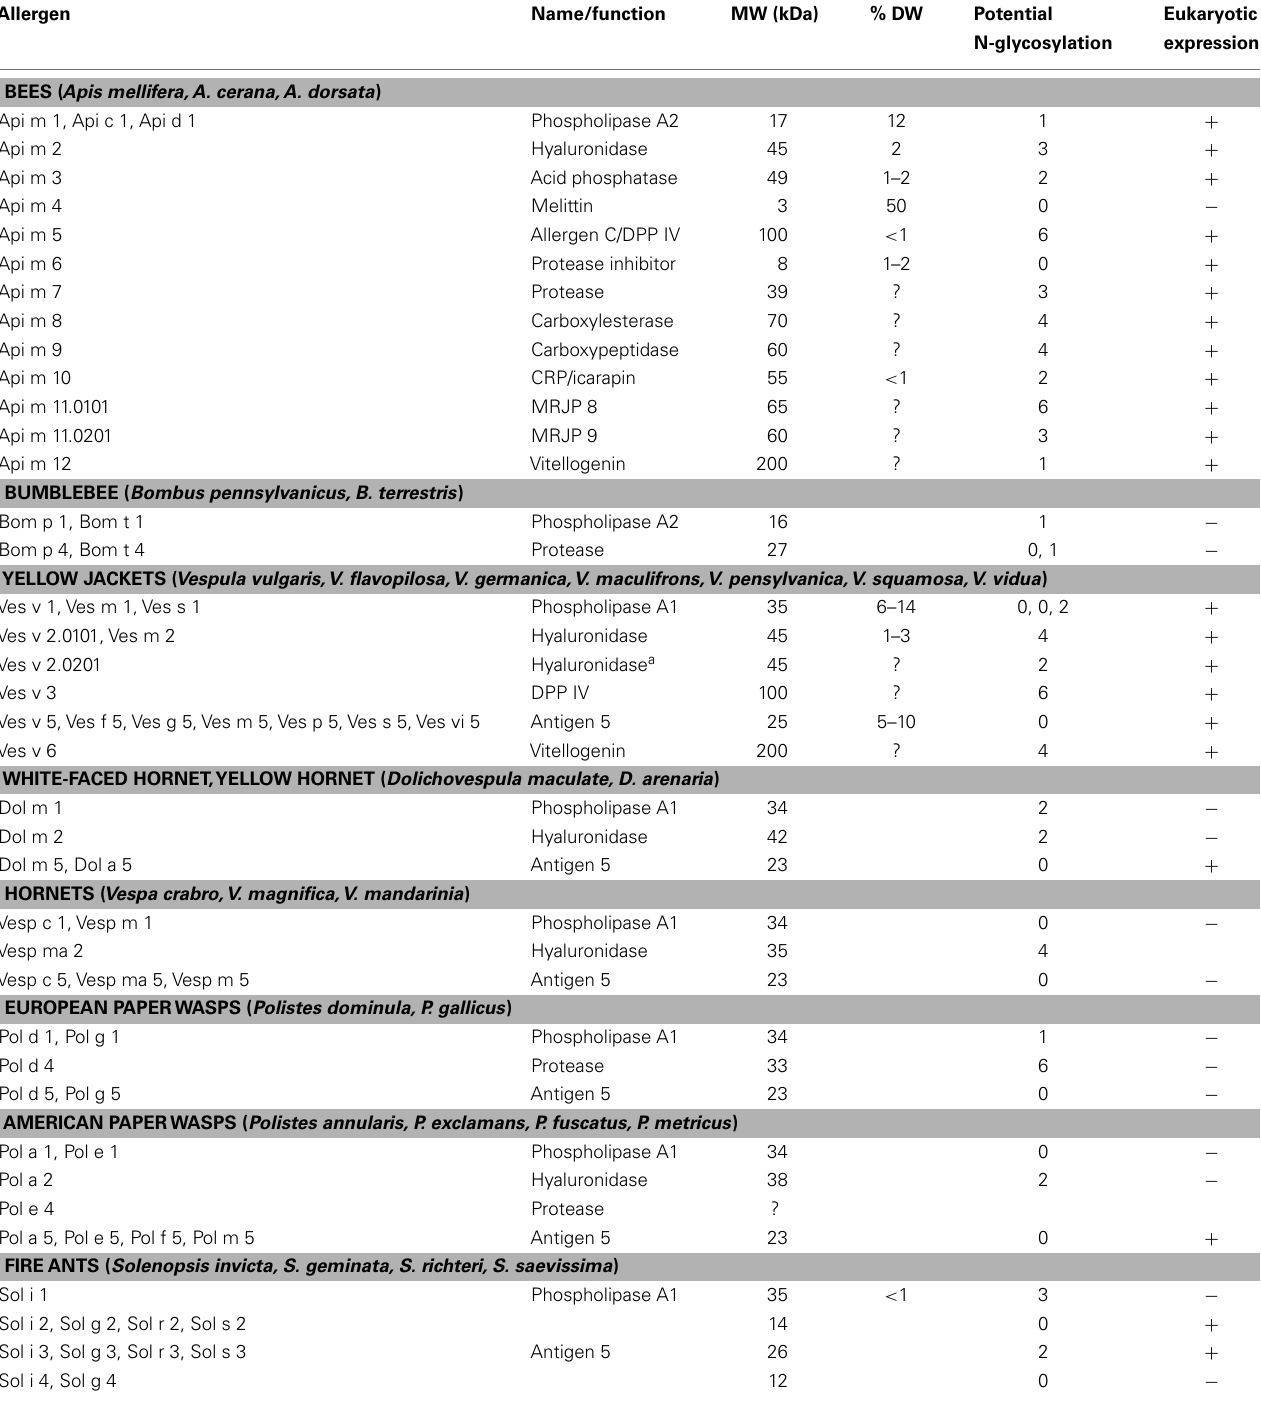
Table 1 | Overview about the presently known Hymenoptera venom allergens .